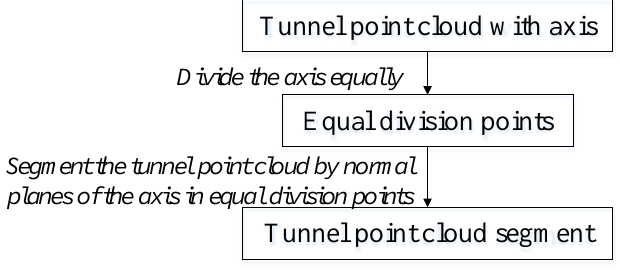
Figure 4. Flow chart of the tunnel point cloud segment